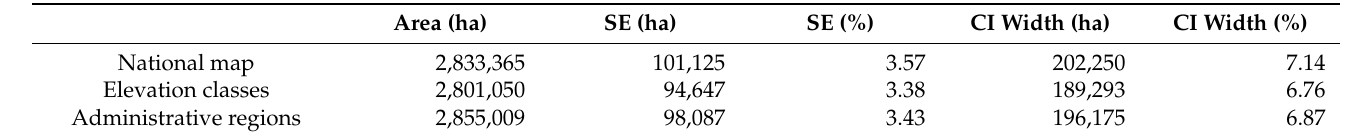
Table 2. National afforestation area estimates.